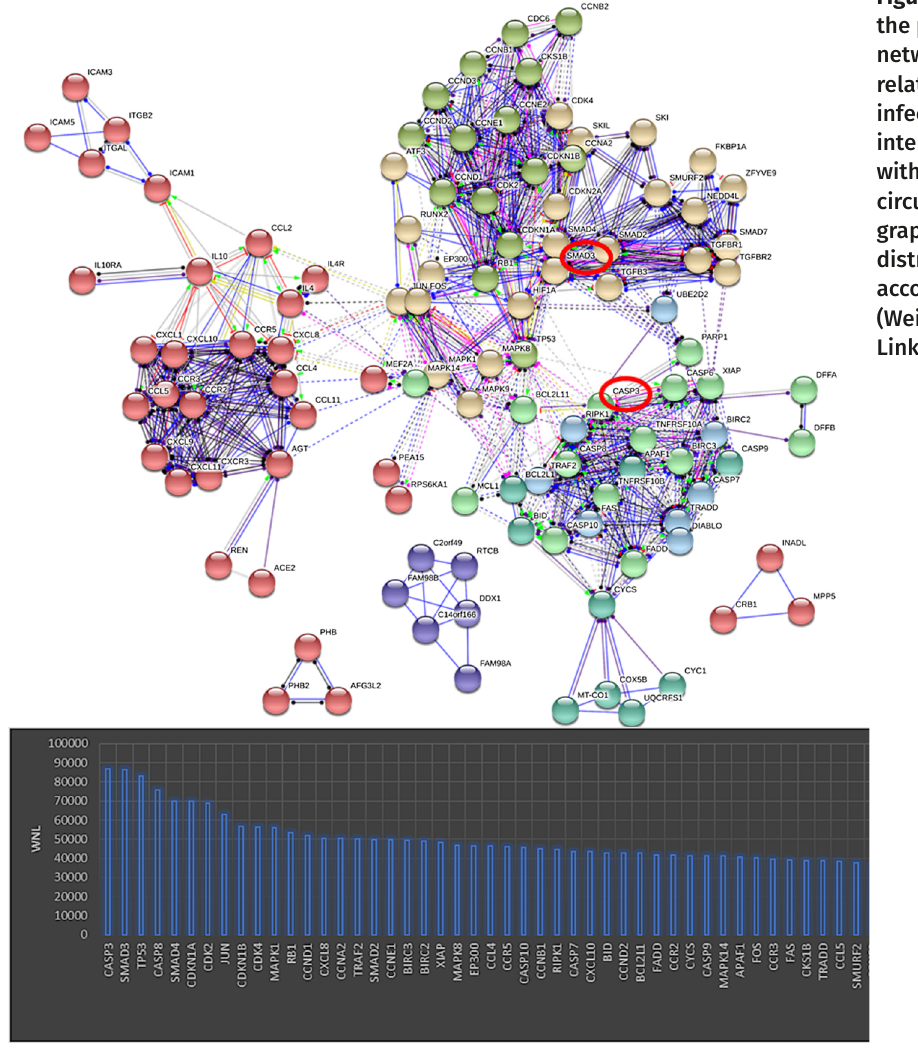
Figure 1. Leader genes in the protein interaction network between genes related to the SARS-CoV-2 infection. (a) protein interaction network with the leader genes circulated in red. (b) The graph representing the distribution of genes according to the WNL (Weighted Number of